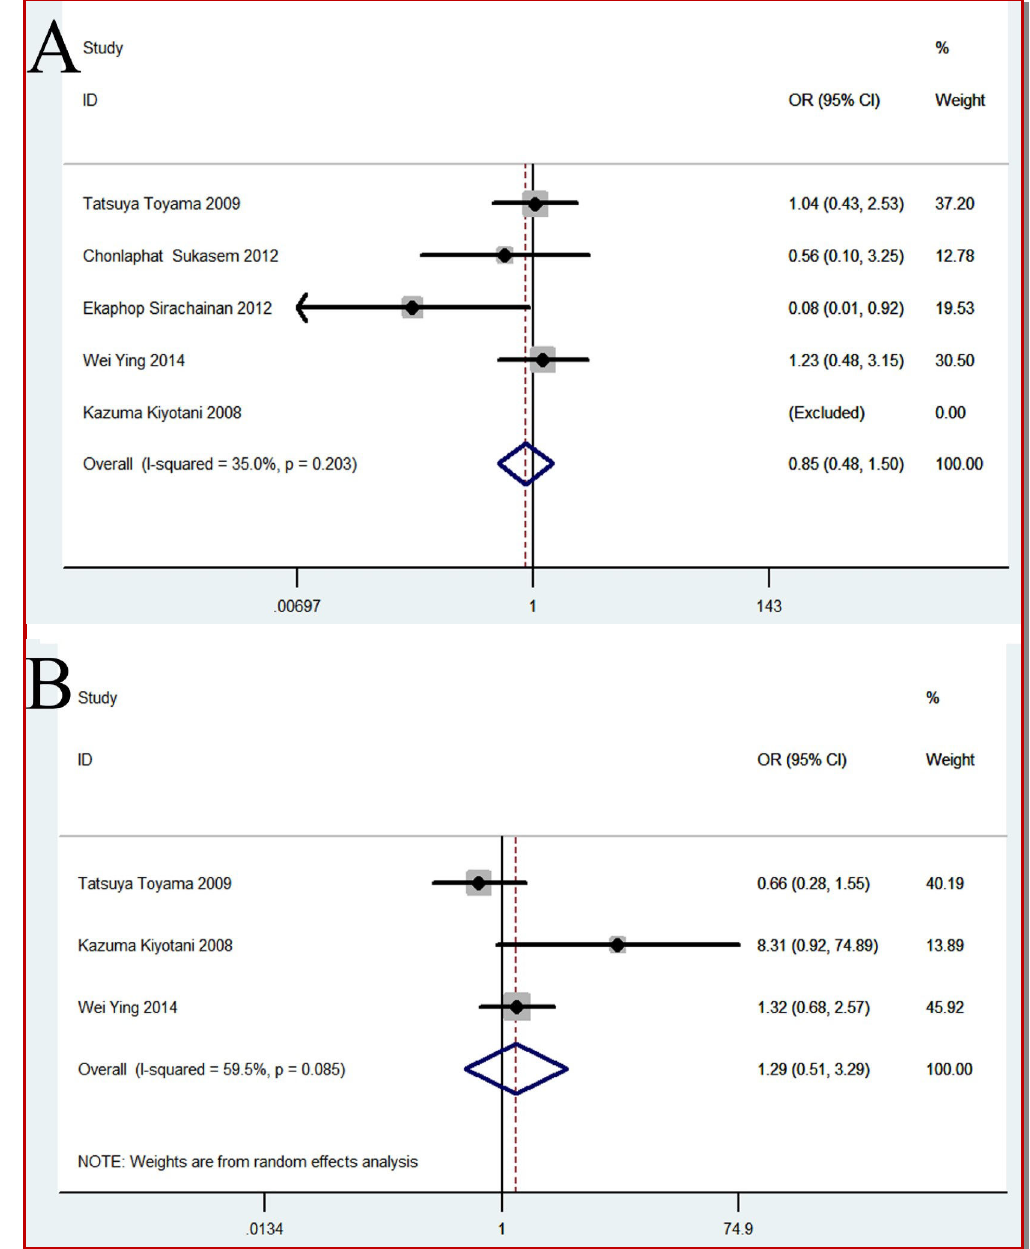
Figure 3: Meta-analysis for 5 years-DFS of CYP2D6 Wt/Wt vs Wt/*10. (A): 5 years-DFS; (B): 10